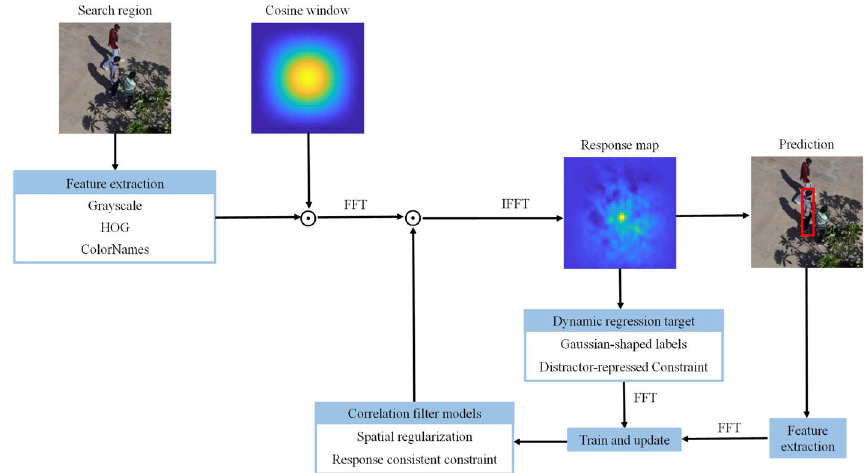
Fig. 4 Flowchart of the proposed